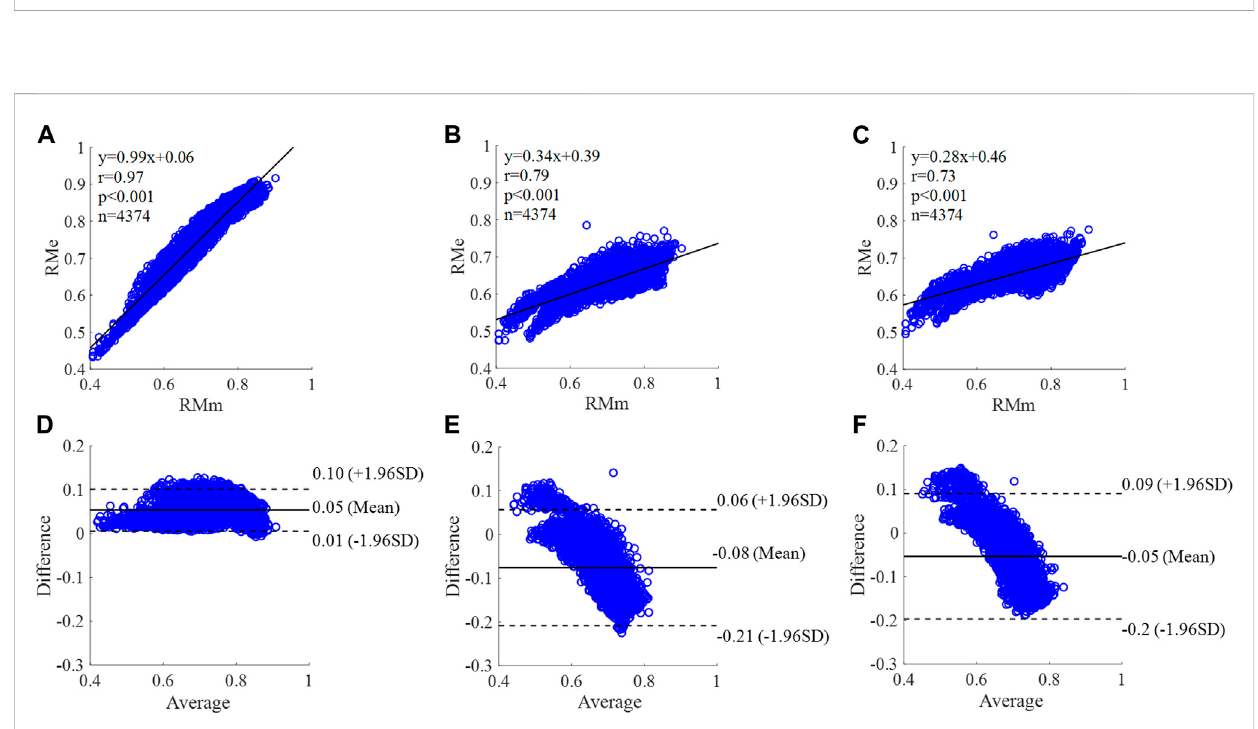
FIGURE 10 Correlation graphs and Bland-Altman plots of RM calculated by three fl ow waveforms (A) and (D) Results of the personalized fl ow wave (Nektar1D PWDB, 4,374 subjects); (B) and (E) Results of the triangular fl ow wave (Nektar1D PWDB, 4,374 subjects); (C) and (F) Results of the lognormal fl ow wave (Nektar1D PWDB, 4,374 subjects). RMm and RMe are measured and estimated RM, respectively. Difference: RMe - RMm; Average: (RMe +